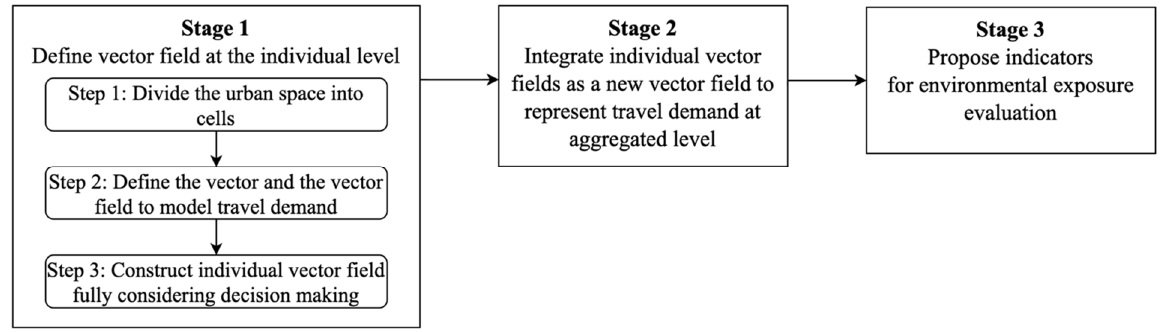
Figure 1. Methodological framework.